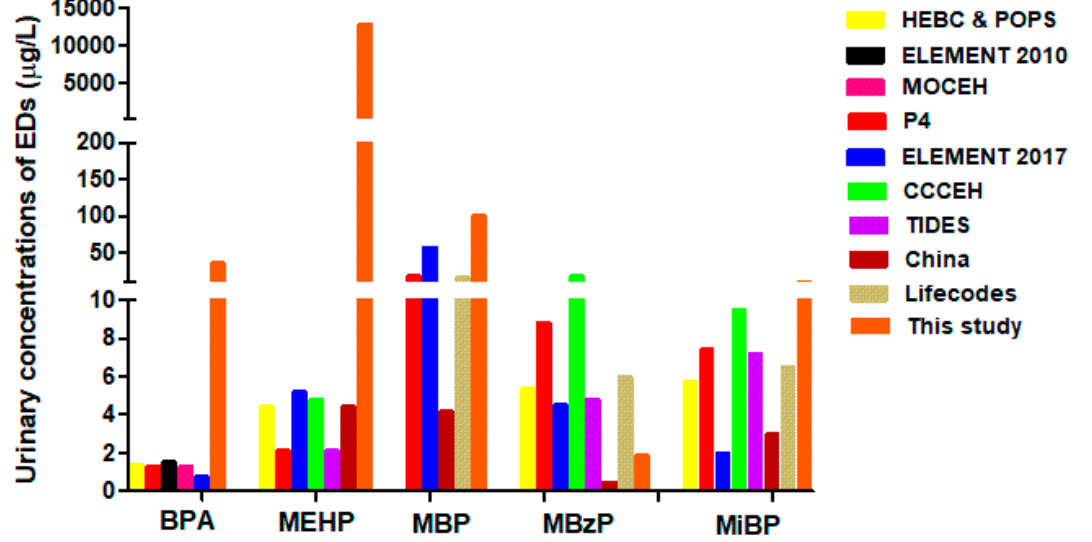
Figure 3. Comparison of median concentrations of total BPA and phthalates metabolites in urine from several cohorts.